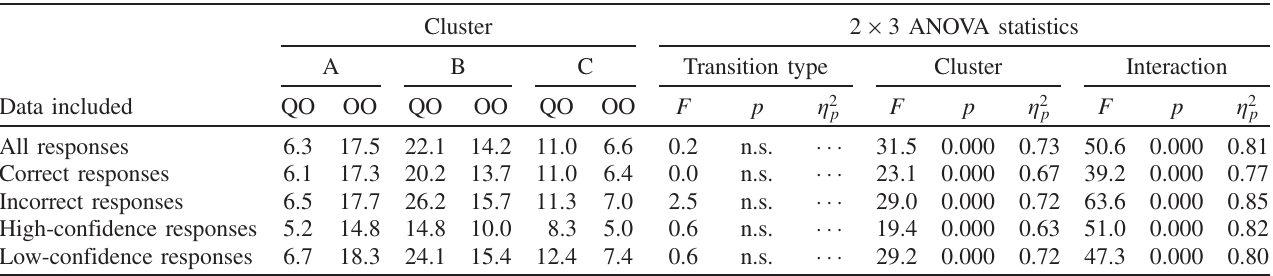
TABLE II. Number of eye movement transitions for subsamples of the dataset and ANOVA